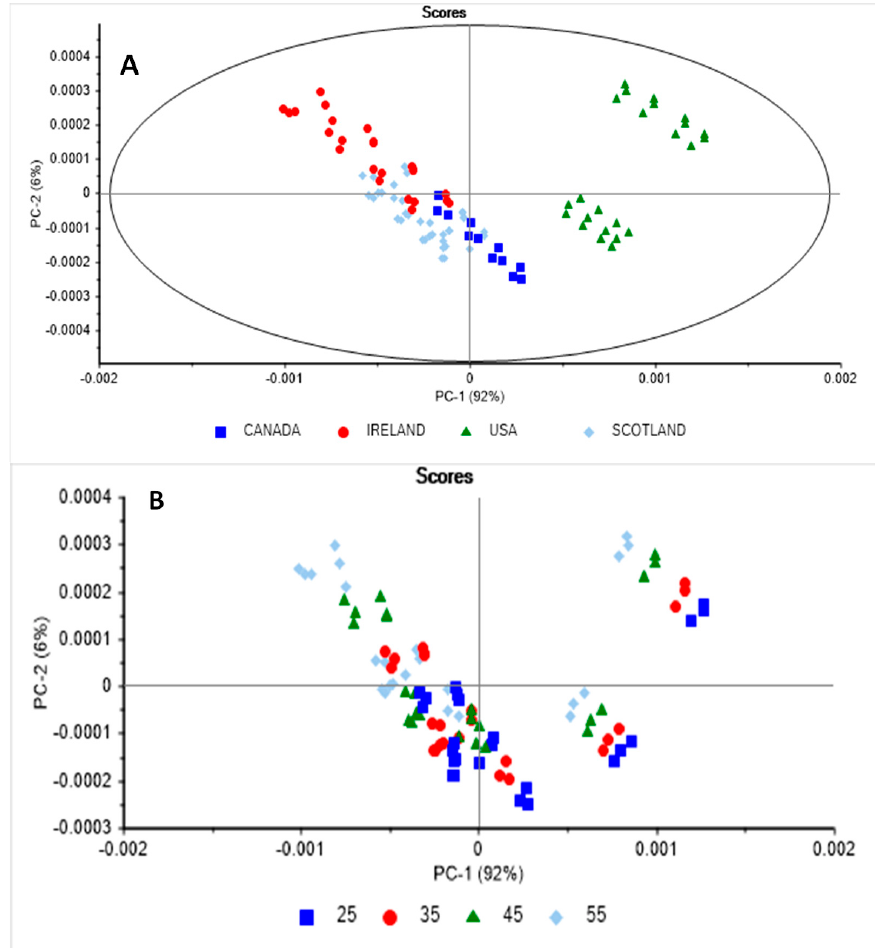
Figure 4. Principal component score plot of whisky samples analysed UV-VIS spectroscopy. ( A ): label by whisky, ( B ): label by scanning temperature. Appl. Sci. 2019 , 9 , x FOR PEER REVIEW